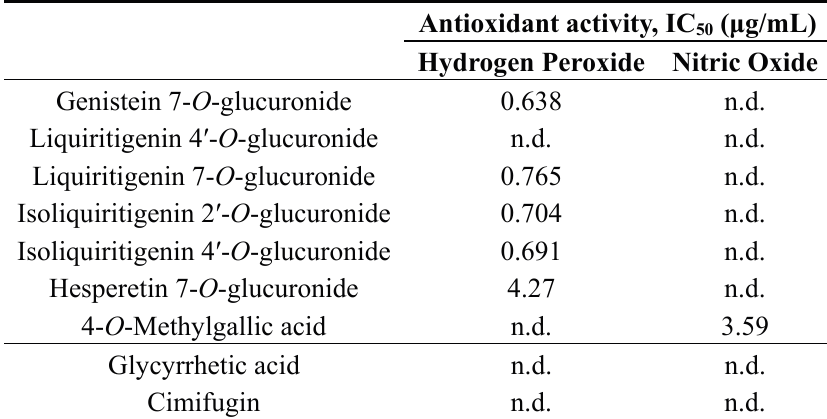
Table 3. Antioxidant activity of metabolites absorbed in